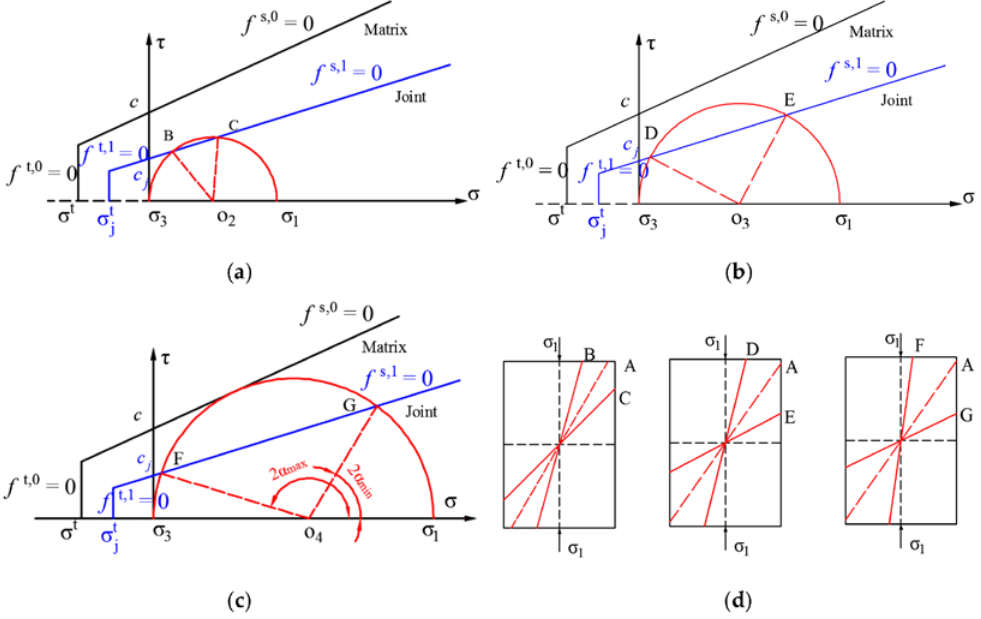
Figure 6. Failure criterion for intact rock and joint set in combination with different stress states: ( a ) Position B and C, ( b ) Position D and E, ( c ) Position F and G, ( d ) illustration of corresponding orientations of weak planes.